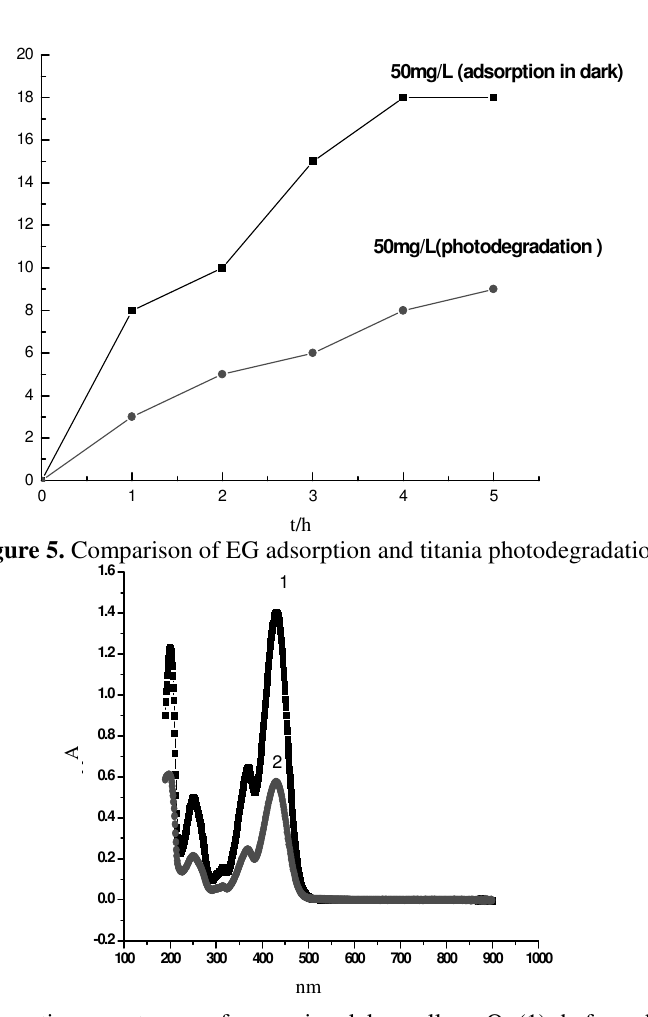
Figure 6. Absorption spectrums of auramine lake yellow O (1) before